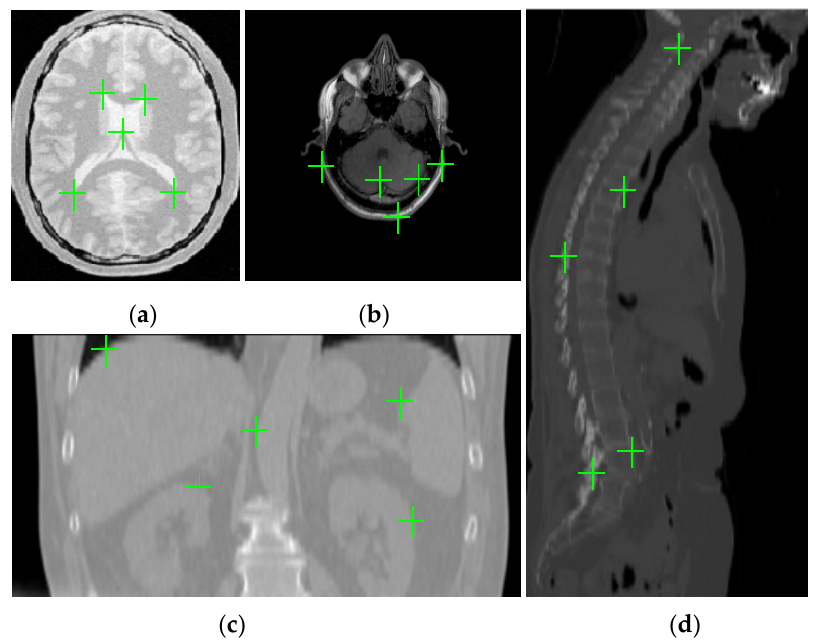
Figure 4. Landmarks in one slice of three-dimensional (3D) medical images. ( a ) simulated probability density (PD) weighted image; ( b ) real T1 weighted image; ( c ) abdomen computed tomography (CT) image; and, ( d ) whole-body CT image.